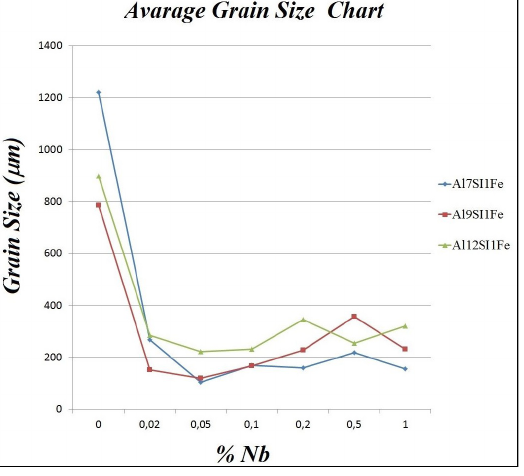
Figure 8. Average Grain Size according to Nb wt.